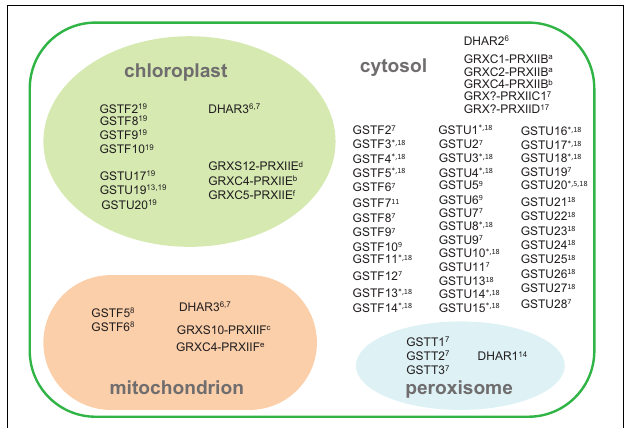
FIGURE 2 | Subcellular compartmentation of GSH-oxidizing enzymes, based on available information. Numbers and “ ∗ ” indicate references given in Supplemental Table 1 except for the following, indicated in the figure by letters in superscript: a Riondet et al., 2012; b Bréhélin et al., 2003; c Finkemeier et al., 2005; d Gama et al., 2008; e Rouhier et al., 2005; f Couturier et al., 2011. Abbreviations as in Figure 1 legend. GRX-PRX partnerships are indicated for proteins shown to functionally interact in peroxidase activity, but these proteins may also interact with other